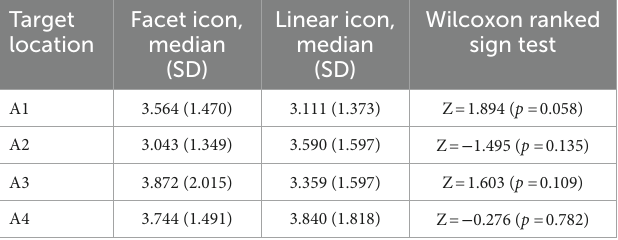
TABLE 5 Results of the fixation count along the different locations.